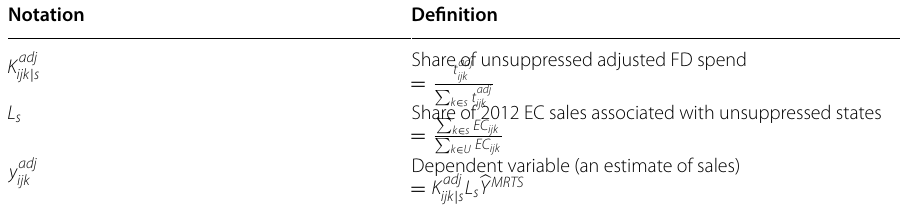
Table 6 Dependent variables notation